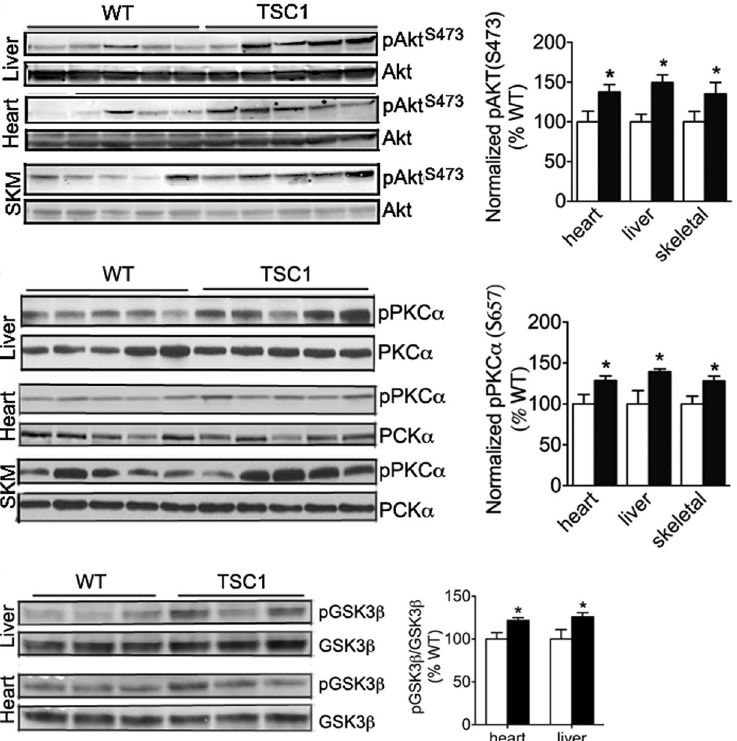
Figure 4. Changes of mTORC2 related signaling in TSC1 tg mice. ( a ) Phosphorylation of ATK at serine 473 and ( b ) Phosphorylation of PCK α at serine 657 in the heart, liver and skeletal muscle (SKM). ( c ) Phosphorylation of GSK3 β at serine 9 in liver and heart. The protein band intensity was normalized to wild type mice in each group. The asterisks indicate statistical significance between Tsc1 tg and wild type mice ( * p < 0.05, n = 6 for each group, includes both male and female mice).